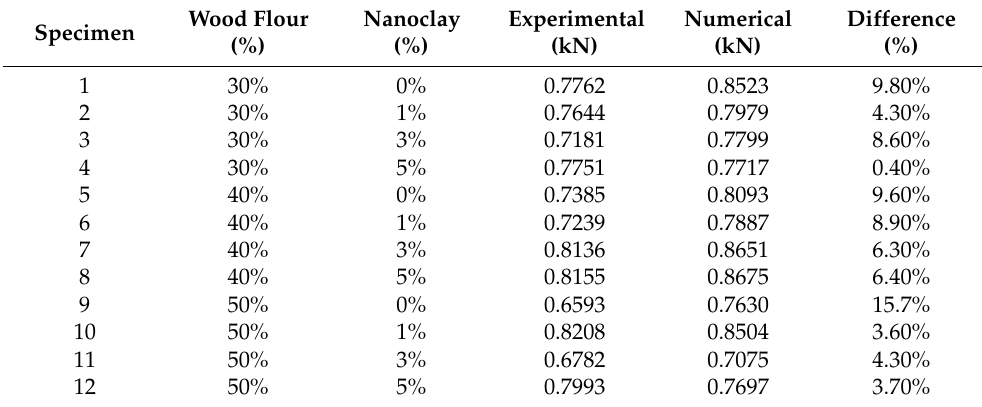
Table 11. Comparison of the failure force in the experimental and numerical bending test.